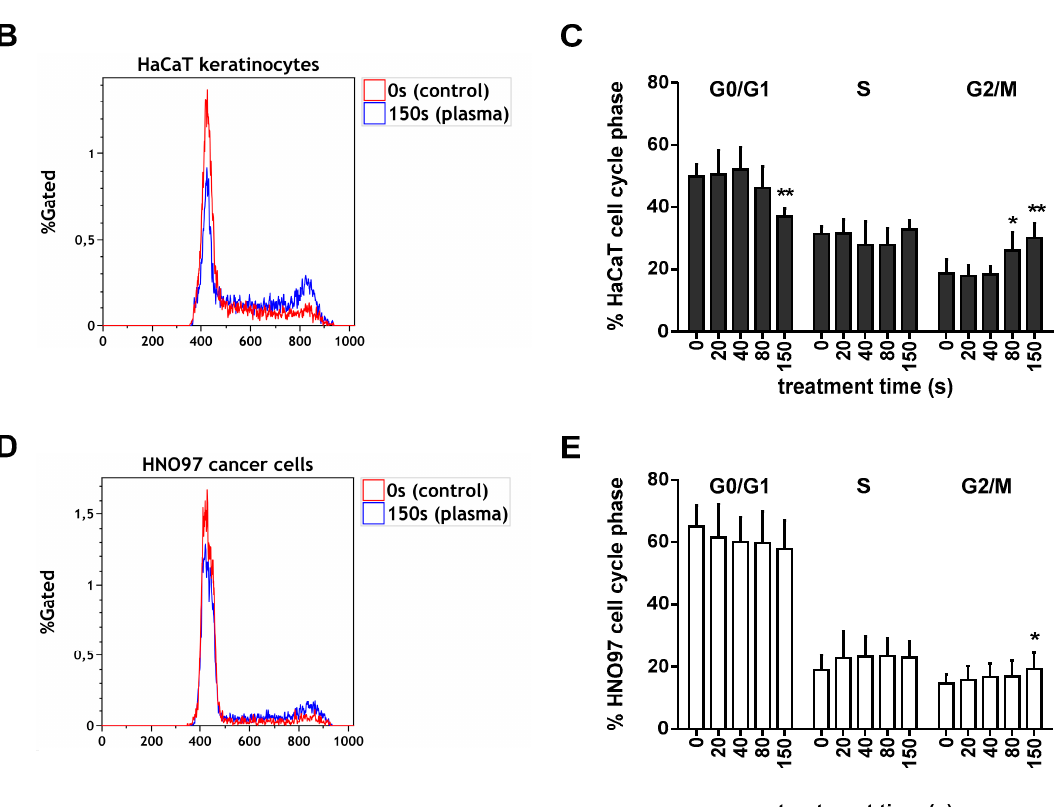
Figure 2. Comparison of the viability of HaCaT keratinocytes (blue line) and HNO97 (black line) in response to cold atmospheric pressure plasma (CAP) treated cell culture medium. ( A ). Cell viability is reduced after CAP treatment in both cell lines similarly. Formation of resorufin is plotted as a function of treatment time (log scale). Both curves summarize two individual experiments with 12 single measurements. 50 % of viable cells (IC 50 ) are reached after CAP treatment for 31 s and 36 s, respectively. Cell cycle analyses revealed a G2/M-arrest in HaCaT keratinocytes and HNO97 cancer cells by CAP treated cell culture medium. Representative histograms for control (red line) and 150 s treatment time (blue line) are displayed for HaCaT keratinocytes ( B ) and for HNO97 cancer cells ( D ). Both, HaCaT keratinocytes and HNO97 cells responded by a G2/M arrest with increasing CAP exposure time, most pronounced at 80 s and 150 s ( C and E ).